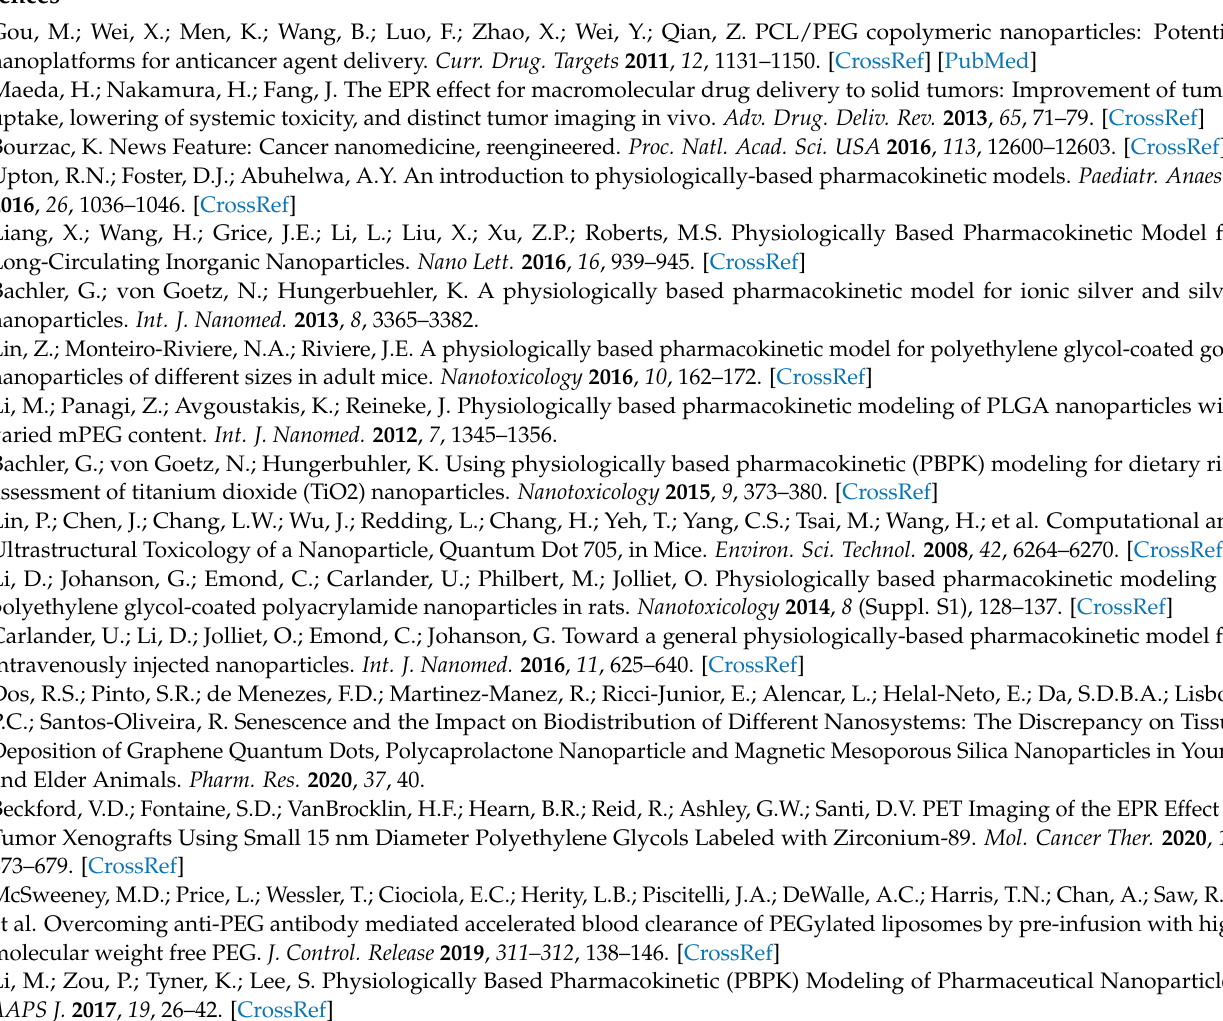
Table S3: Physiological parameters used in the PBPK model for NPs in mice, Table S4: Relative sensitive analyses for the parameters of mPEG5k-9.09%-80 nm NPs, Table S5: Relative sensitive analyses for the parameters of mPEG5k-28.57%-80 nm NPs Table S6: Relative sensitive analyses for the parameters of mPEG5k-9.09%-200 nm NPs, Table S7: Relative sensitive analyses for the parameters of mPEG5k-28.57%-200 nm NPs, Table S8: Relative sensitive analyses for the parameters of mPEG5k-28.57%-200 nm